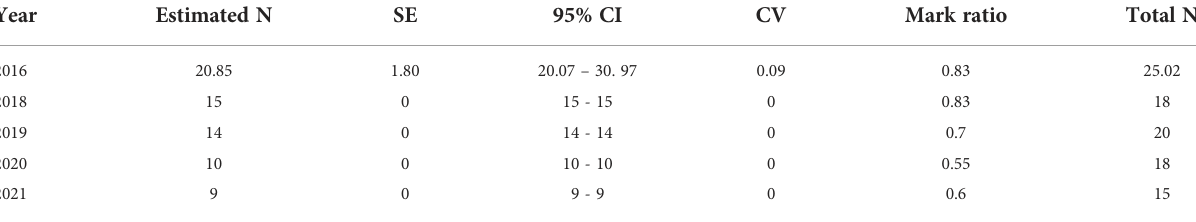
TABLE 6 Yearly abundance estimates for the common dolphins.